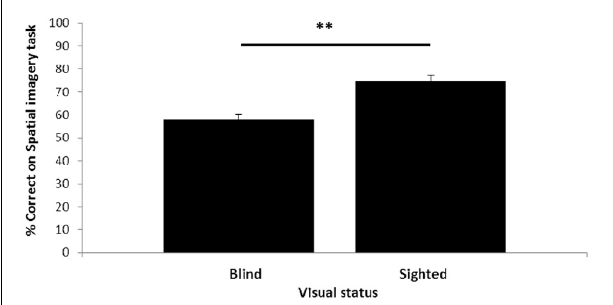
FIGURE 2 | Relationship between visual status and spatial imagery task performance. Error bars: standard error of the mean (s.e.m.) ∗∗ p < 0 . 1.